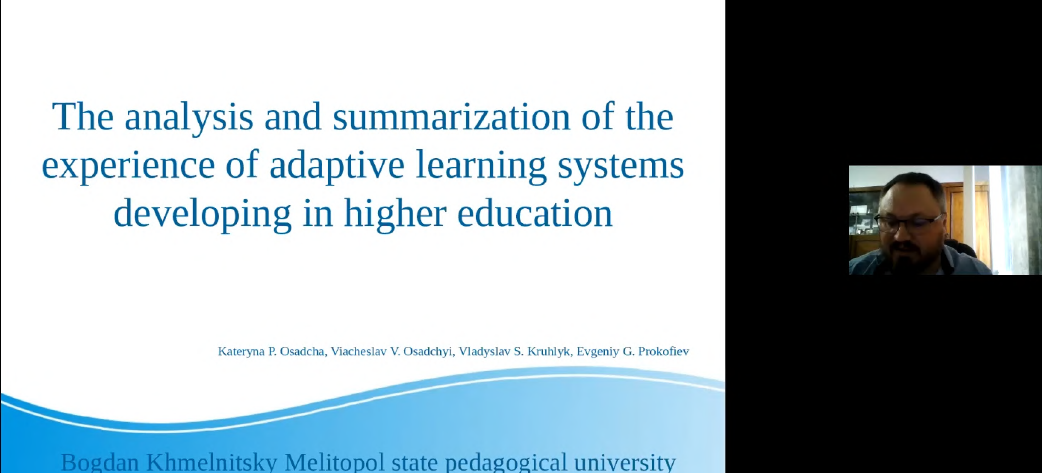
Figure 44: Presentation of paper [184].